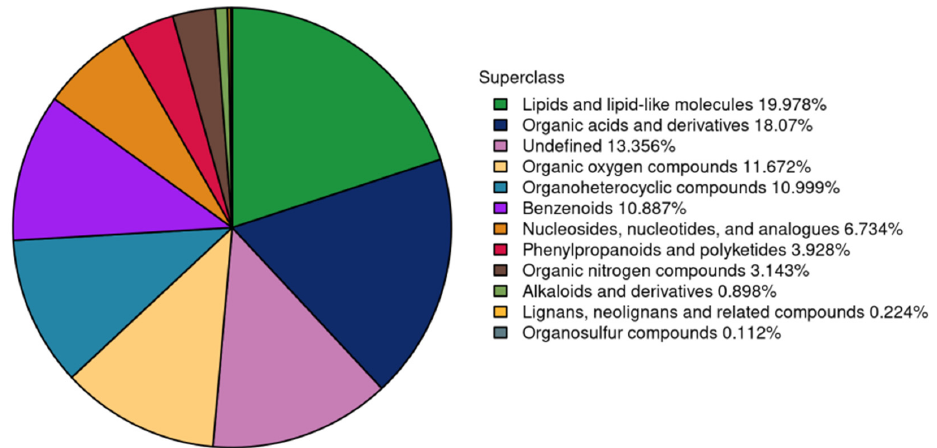
Figure 5. The number proportion of the identi fi ed metabolites in each chemical classi fi cation.